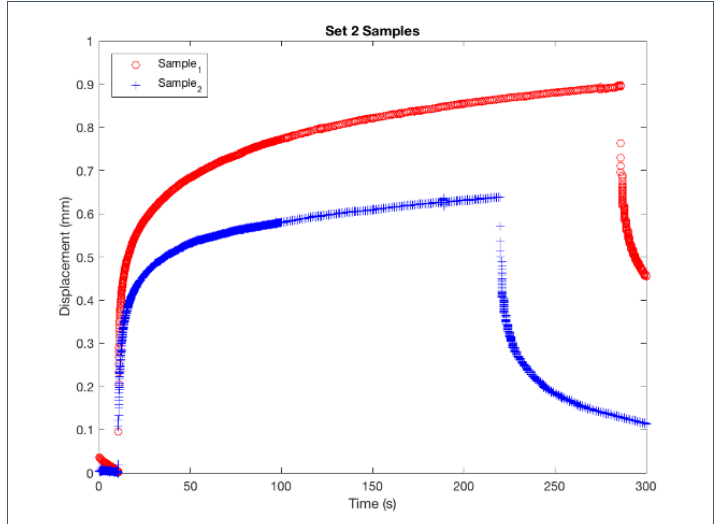
Figure 5. Set 2 Geometry Z -Axis Displacement.